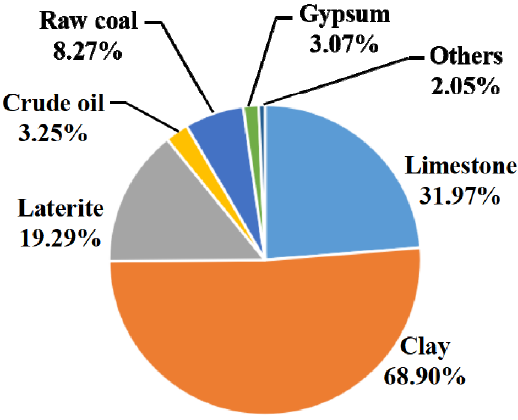
Figure 8. Environmental impacts to ADP of each substance in OPC with Chinese data.